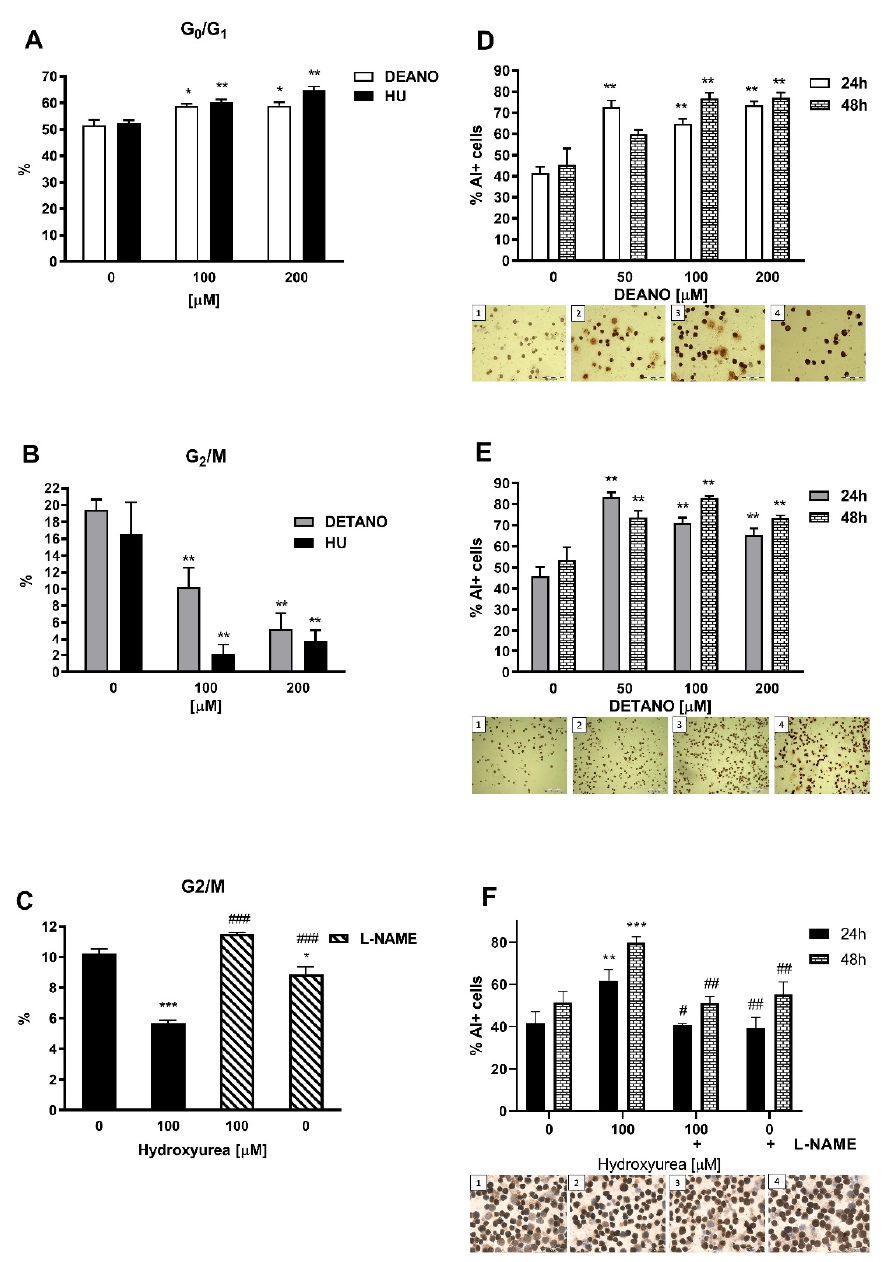
Figure 3. The influence of NO donors and hydroxyurea (HU) on cell cycle and apoptosis in erythroleukemic K562 cells. Using flow cytometry, we measured the percentage of PI positive cells in K562 cells treated with ( A ) HU and DEANO after 48 h at G 0 /G 1 phase; ( B ) HU and DETANO after 24 h at G 2 /M phase; and ( C ) HU and L-NAME after 48 h at G 2 /M. Apoptotic index (AI) after 24 and 48 h of ( D ) DEANO; ( E ) DETANO; and ( F ) HU treatment with or without L-NAME (100 µM). The apoptotic rate was expressed as the percentage of ssDNA-positive nuclei per total nuclei (apoptotic plus non-apoptotic nuclei). Immunocytochemistry images correspond to results after 48 h. Values are mean ± SEM (n = 4–6). * p < 0.05, ** p < 0.05 and *** p < 0.001 compared to the untreated cells (0). # p < 0.05, ## p < 0.01, and ### p < 0.001 compared to only HU treated cells (100).